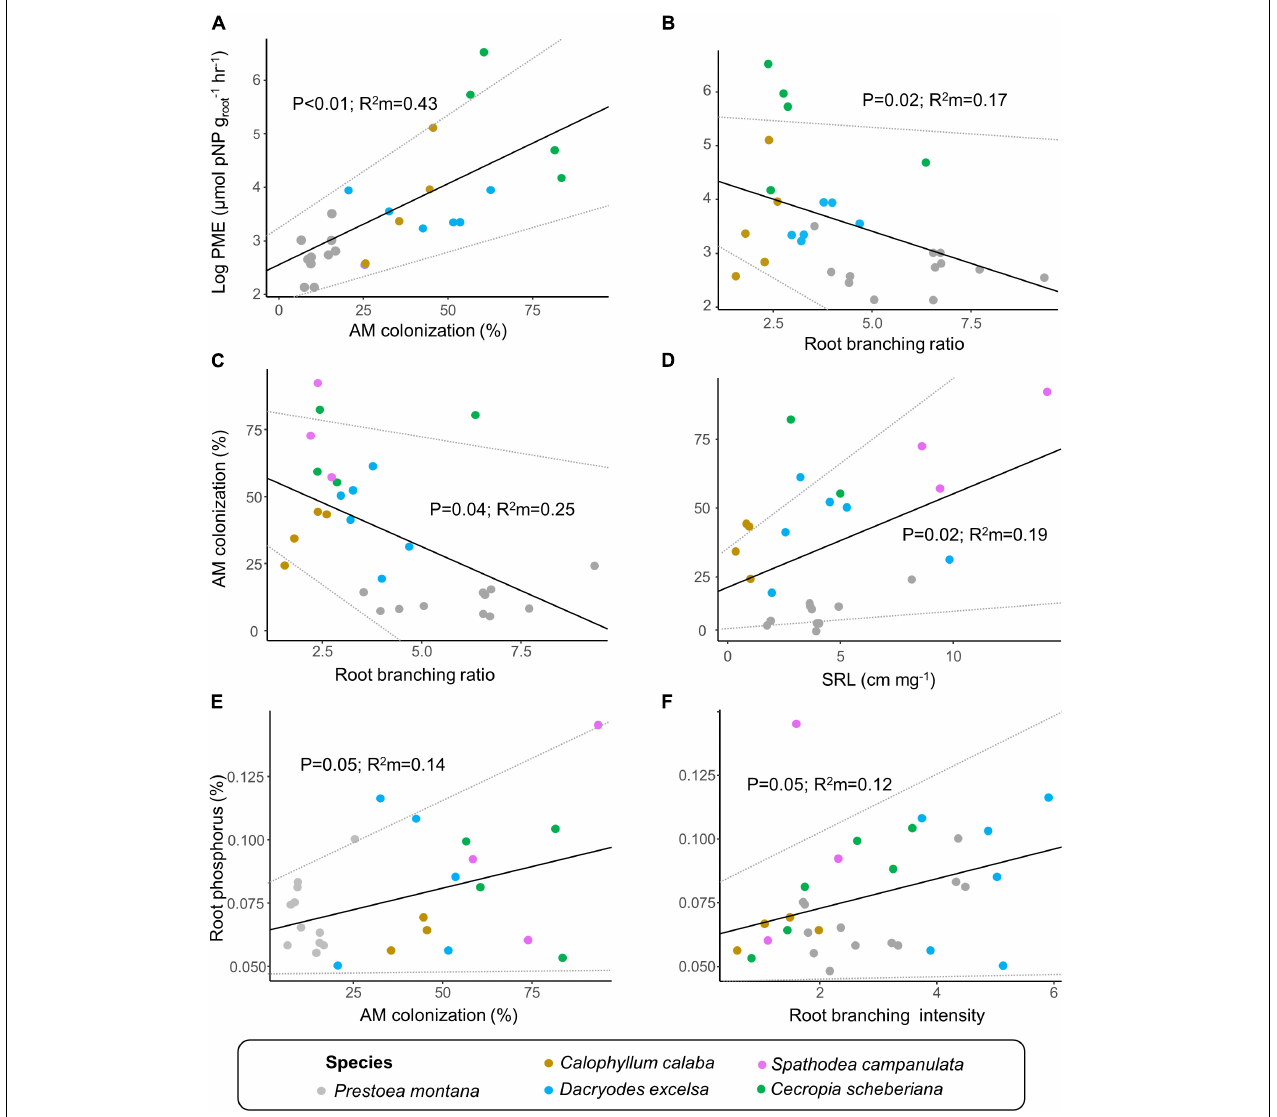
FIGURE 4 | Bivariate significant relationships among the seven fine-root traits measured in this study. Linear mixed-effects models were fitted for each root trait combination to account for the hierarchical nature of our dataset (see Supplementary Table 2 ). We report the marginal R 2 of each model which represents the variance explained by the fixed effect. The dotted gray lines represent the confidence interval for a given model parameter. The relationships include root phosphatase activity (phosphomonoesterase; PME) with (A) arbuscular mycorrhizal (AM) colonization and with (B) root branching ratio; AM colonization with (C) root branching ratio and with (D) specific root length (SRL); and root phosphorus concentration with (E) AM colonization and with (F) root branching intensity. Data are shown after the hurricanes that passed over the island in 2017. Due to sampling constraints, root PME activity was not measured for Spathodea campanulata